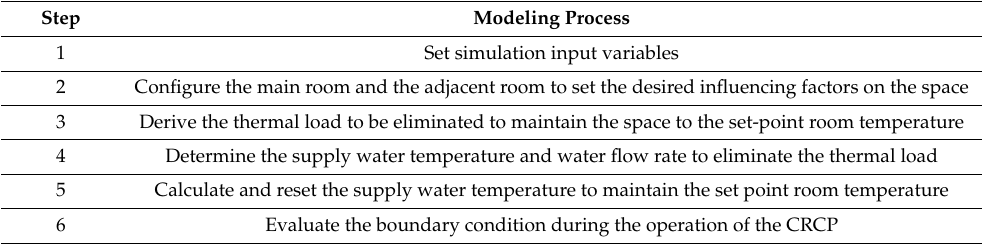
Table 8. Modeling process to evaluate the boundary